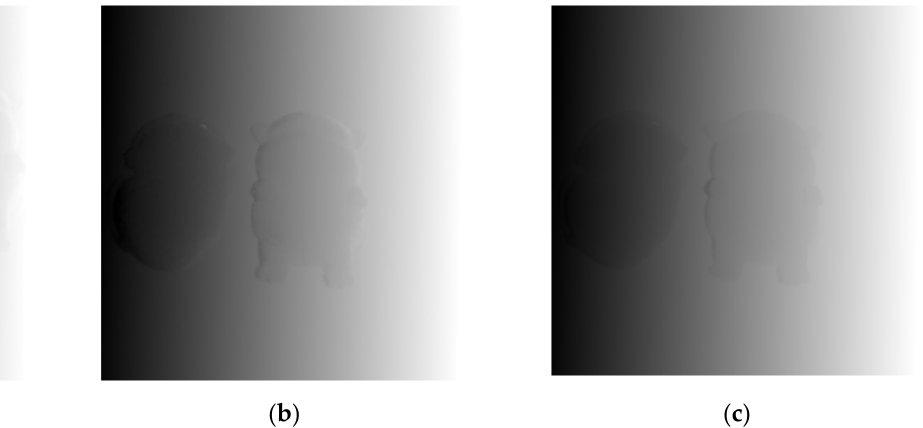
( d ) Figure 7. The reconstructed results. ( a,b ) The result obtained by the proposed method; ( c , d ) the reconstructed result with the traditional PSP. The RMS (root mean square) error is employed to evaluate the accuracy of the pro- posed method. The true value of the object is obtained by the eight-step traditional PSP